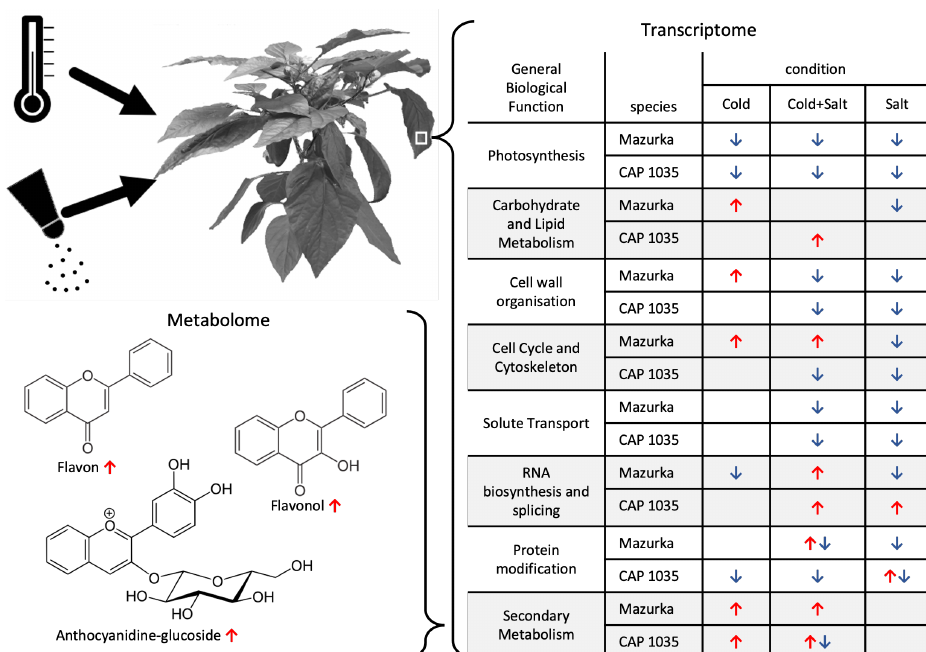
Figure 10. Mid- to long-term response to mild abiotic stress in Capsicum sp. Summary of the observed mid- to long-term response in leaves of Capsicum to chilling temperature, salt treatment and a combination thereof. A significant enrichment (red arrows) or depletion (blue arrows) in different biological pathways and for some putatively annotated secondary metabolites is highlighted.